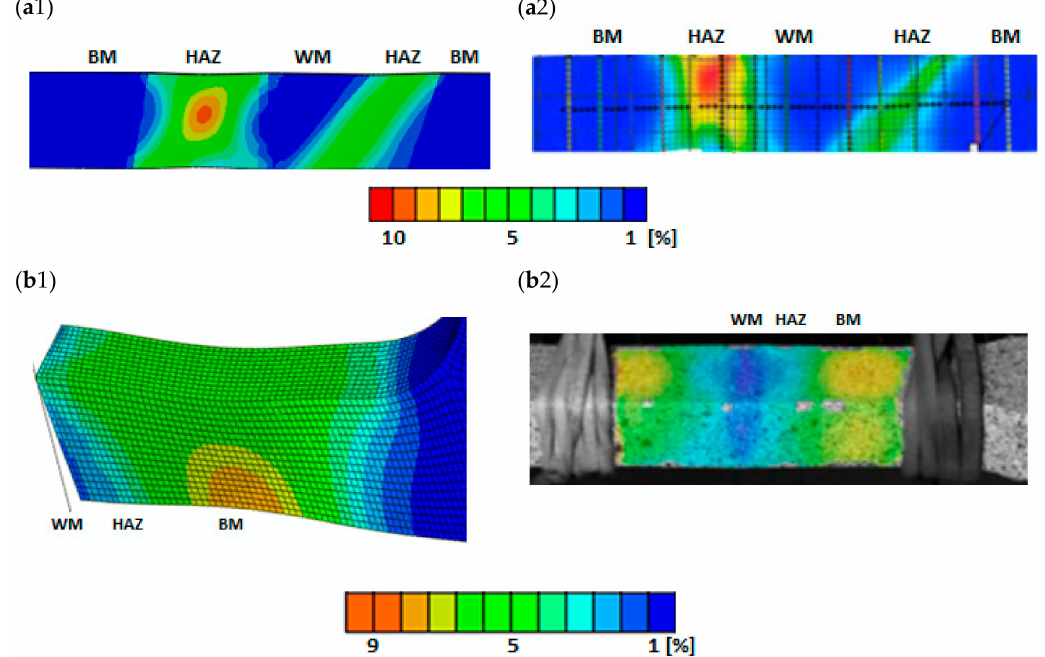
Figure 13. The fields of strains obtained according to FEM ( a 1; b 1) and recorded using video-system ( a 2; b 2) for welded joints Q 3 ( a ) i Q 5 ( b